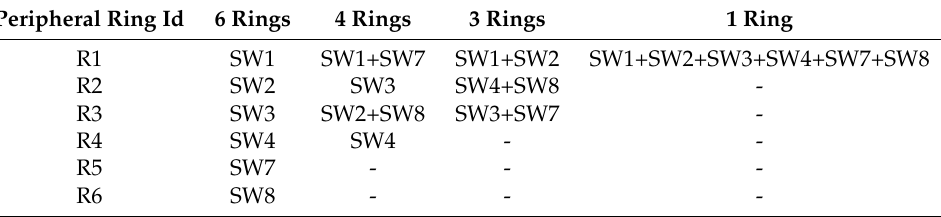
Table 6. Multiple-ring